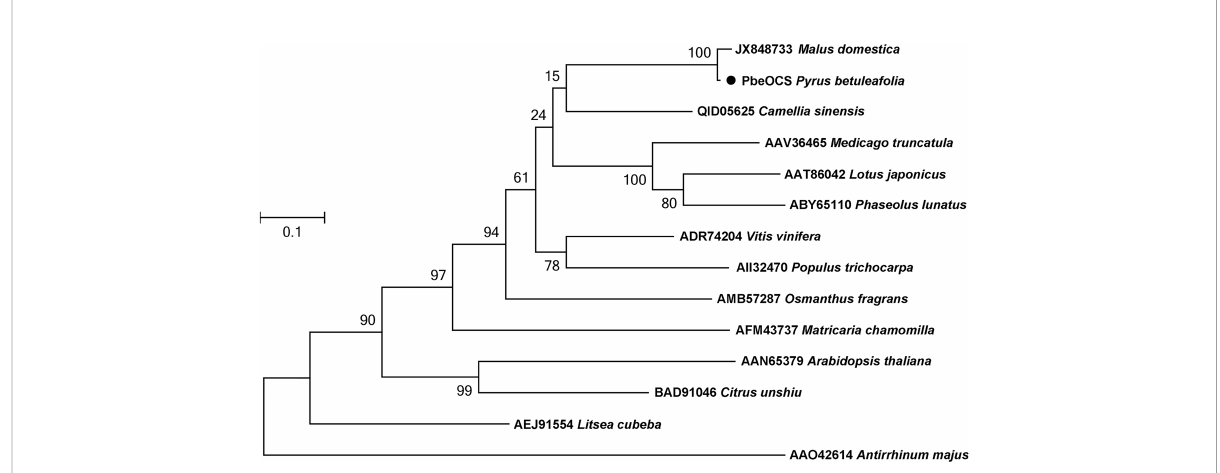
FIGURE 4 Phylogenetic tree of amino acid sequences of PbeOCS from Pyrus betuleafolia and (E) - b -ocimene synthase from other plants. The tree was generated using the maximum-likelihood method with 1,000 bootstrap